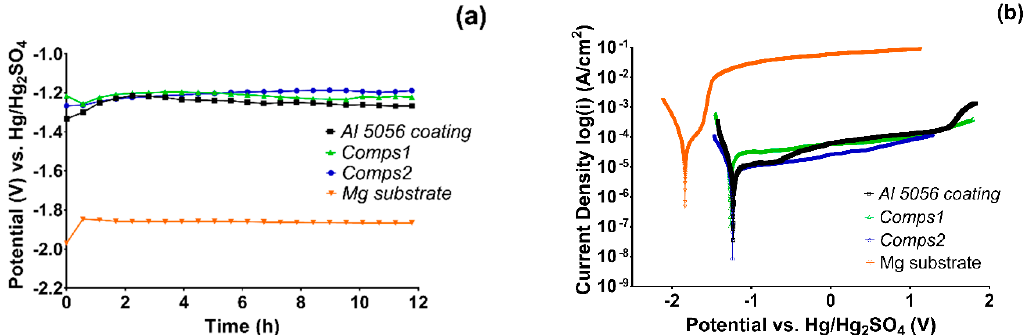
Figure 4. Electrochemical behaviour for the cold-sprayed Al 5056 coating, SiC p /Al 5056 composite coatings and magnesium substrate in 0.1 M Na 2 SO 4 solution: ( a ) open circuit potentials and ( b ) potentiodynamic polarization curves. Table 1. Electrochemical data of the cold-sprayed SiC p /Al 5056 composite coatings and Mg substrate (all potentials are referenced to the Hg/Hg 2 SO 4 electrode).